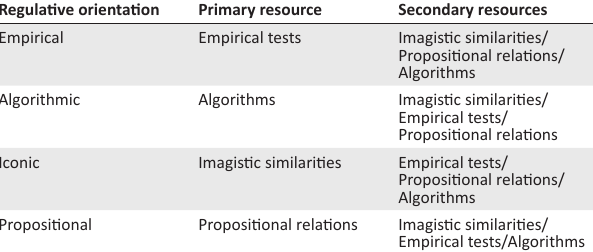
TABLE 2: Summary of revised analytical terms and their relations. Regulative